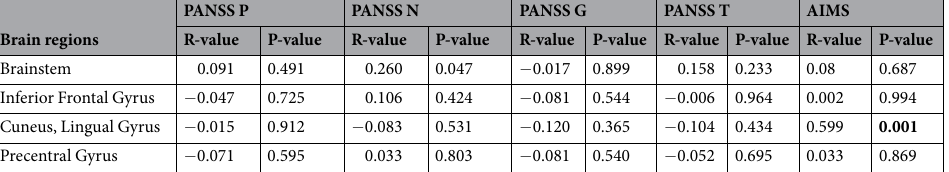
Table 3. Relationship between clinical evaluations and gray matter volume changes derived from the comparison of schizophrenics with and without tardive dyskinesia. PANSS: positive and negative syndrome scale; AIMS, Abnormal Involuntary Movement Scale; BA: Brodmann Area; p -value indicate significant differences ( p < 0.05) in appropriate statistical tests.